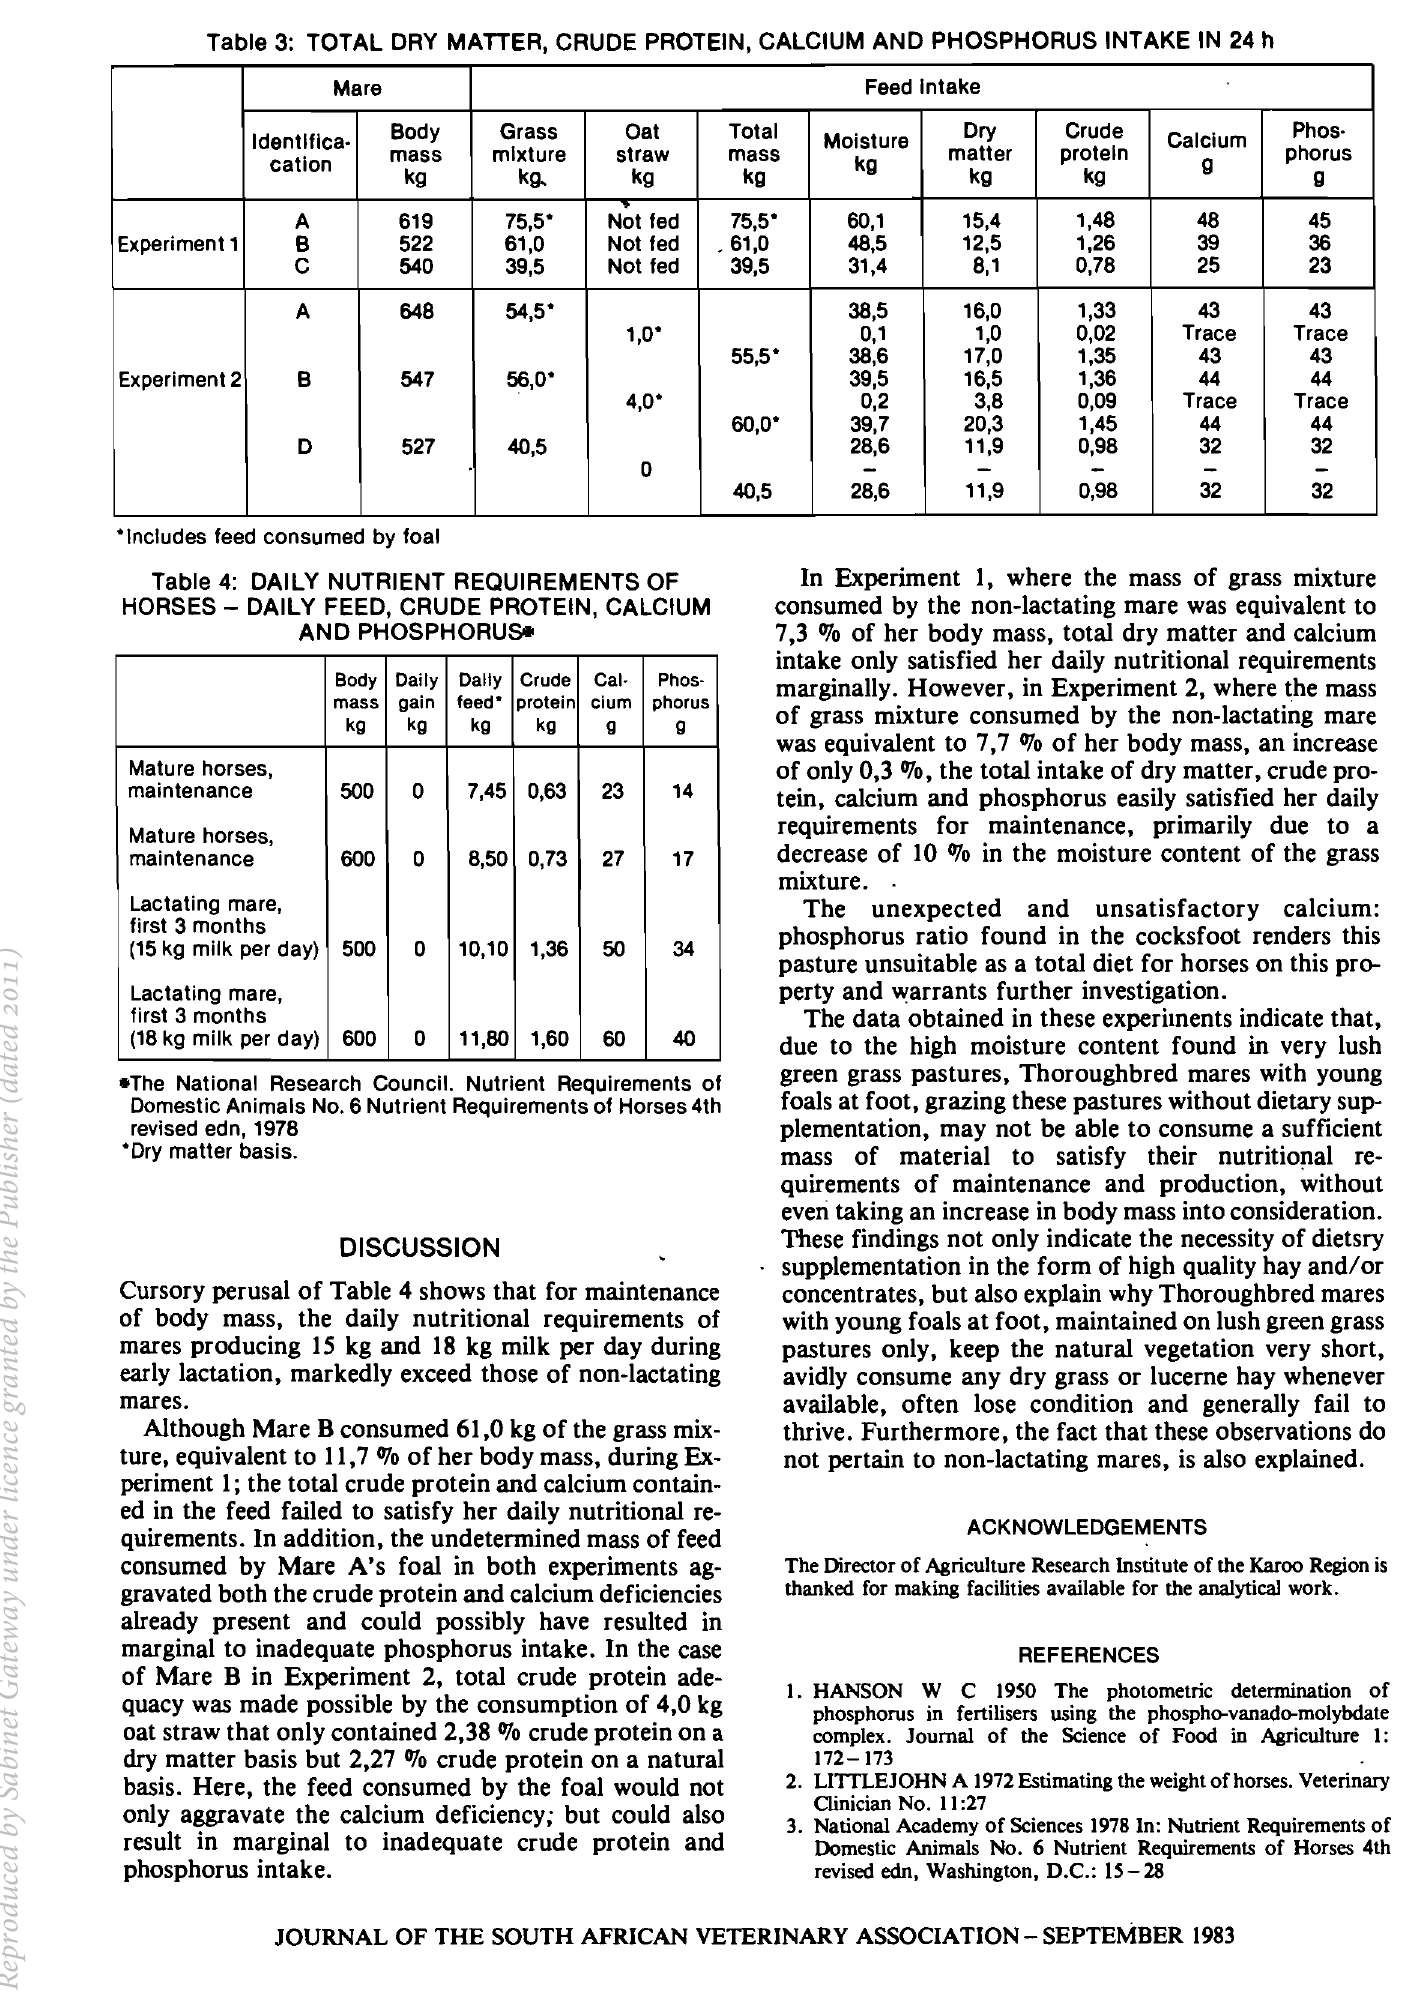
Table 3: TOTAL DRY MAnER, CRUDE PROTEIN, CALCIUM AND PHOSPHORUS INTAKE IN 24 h Mare Feed Intake Body Grass Oat Total Moisture Dry Crude Calcium Phos· Identlflca- mixture straw mass kg matter protein g phorus cation mass kg kg.. 619 75,5" 522 61,0 Not fed .61,0 48,5 540 39,5 Not fed 648 54,5" 1,0" Experiment 2